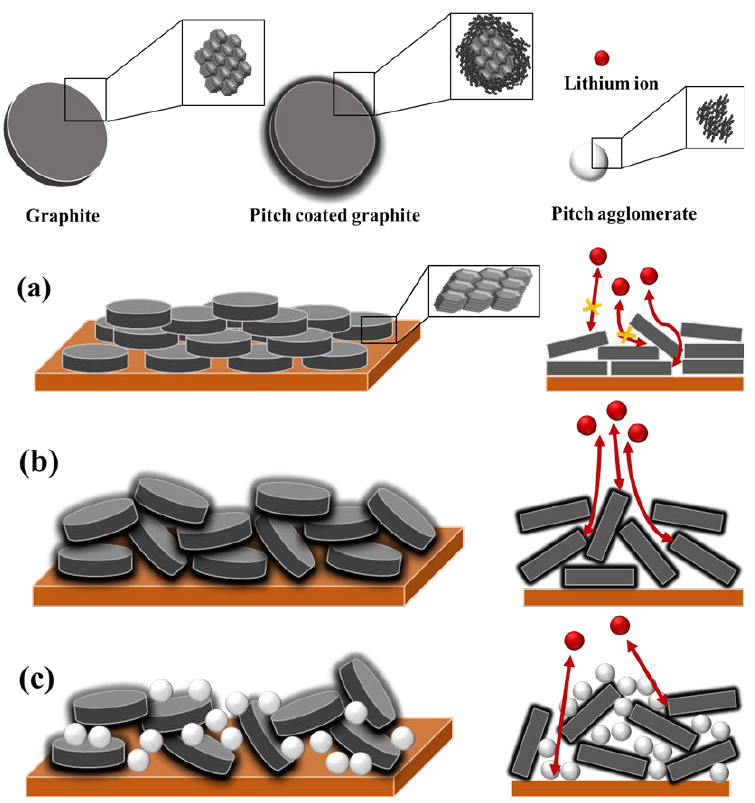
Figure 6. Schematic illustration of electrode structure after pressing process of ( a ) no-coated graphite (FG), ( b ) uniformly pitch-coated graphite (CFG5), and ( c ) excessive pitch-added graphite .